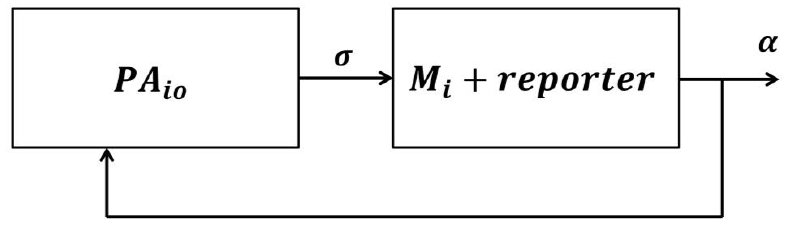
Figure 2. Block diagram of the eCC initiator, patient automaton 𝑷𝑨 𝒊𝒐 , and care provider subsystem: 𝑴 𝒊 with the reporter.